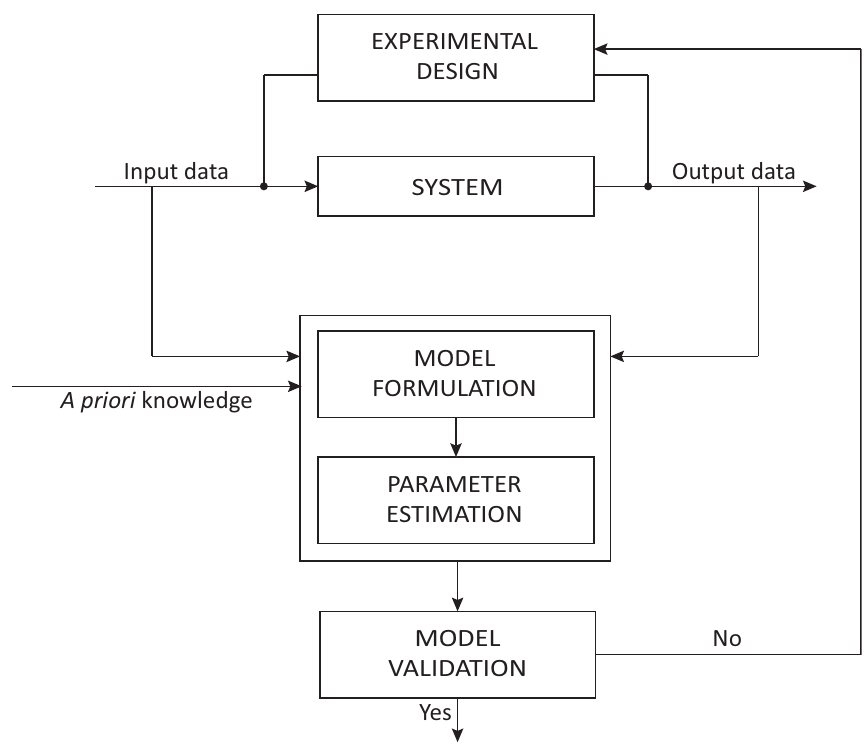
Figure 1. Iterative model identification cycle. The model building process involves the following key steps: experimental design, model structure formulation, parameter estimation, and model